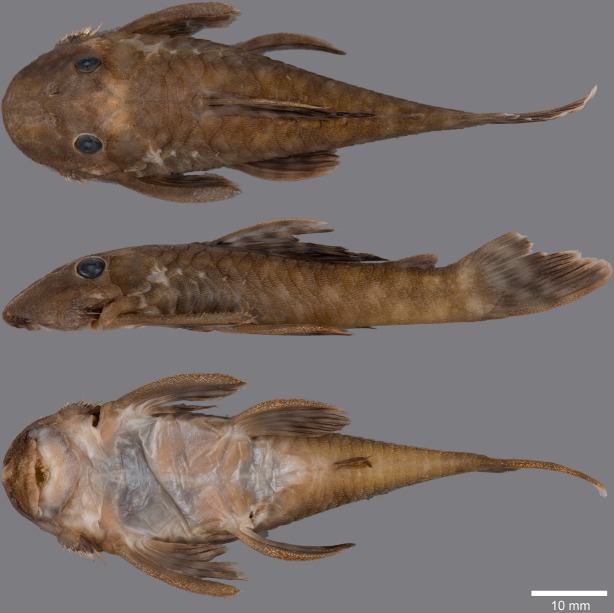
Cryptancistrus similis.MZUSP 117150, holotype, 61.7 mm SL; Brazil: Sipaliwini/Parú Savannah in Trio Amerindian territory at the Suriname-Brazil border, tributary of Parú de Oeste River.